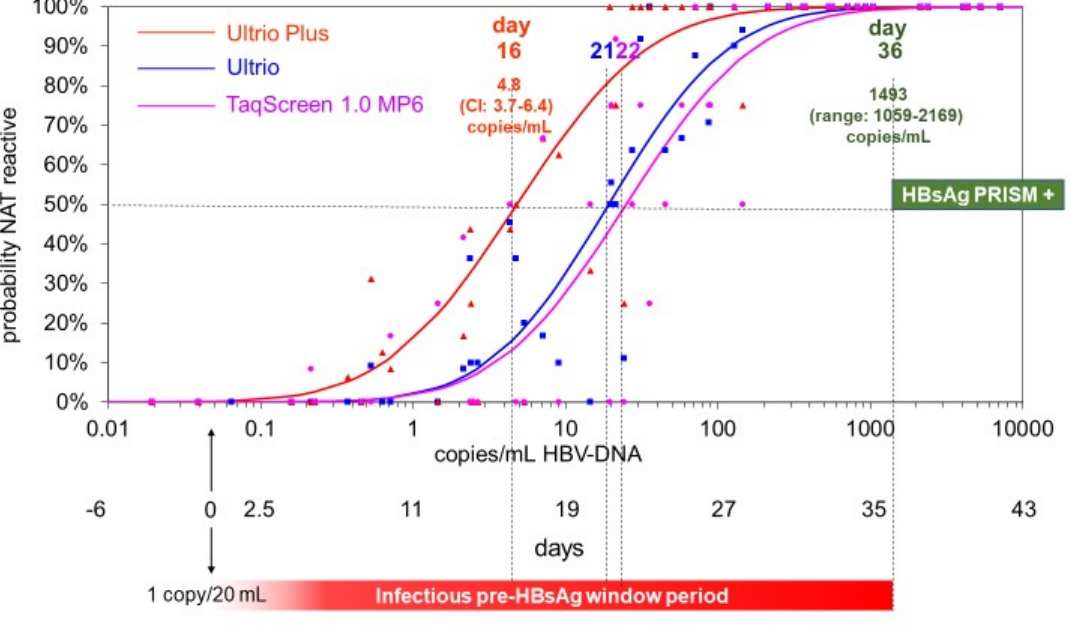
Figure 5. Probability curves calculated from proportions of reactive results obtained by multiple replicate testing ( n = 4–18, Table 2) of five seroconversion panels with three NAT blood screening methods in a combined probit analysis on all seroconversion panel data. The HBV ‐ DNA concentra ‐ tions at the time points on the x ‐ axis were projected from the measured HBV ‐ DNA concentrations in the bDNA 3.0 assay in each of the five panels separately using the regression analysis parameters presented in Table 1. The given time points of the seroconversion samples were shifted so that the start of the infectious window period (day 0) for each of the five panels was set at a concentration of 1 HBV ‐ DNA copy/20 mL plasma (Table 1). The end of the infectious pre ‐ HBsAg window period (red bar under graph) and the beginning of the HBsAg PRISM reactivity (green bar) were set at the geometric mean HBV ‐ DNA concentration at the HBsAg cutoff crossing points estimated for the five panels individually (Table 1, see example Figure 2).